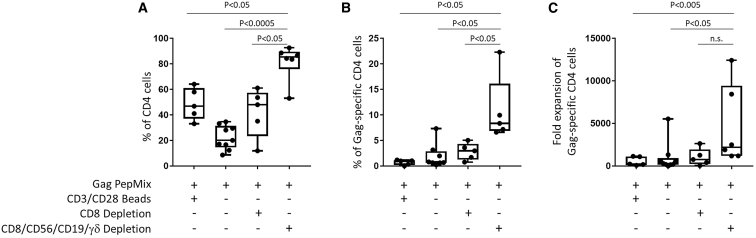
Comparison of the Results of Different Protocols(A and B) The percentage of CD4 (A) and Gag-specific CD4 T cells (B) before and after expansion. (C) Fold expansion of HIV Gag-specific CD4 T cells. Boxplots show all points (min to max) and mean. Mann-Whitney tests were performed. All tests were two-tailed and P values of P<0.05 were considered significant.